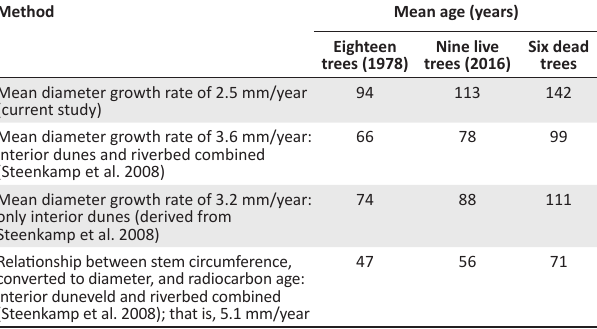
TABLE 1: Age calculations for Vachellia erioloba trees in the interior duneveld at the Dankbaar site using mean stem diameter of the 18 originally marked trees in 1978, the nine remaining live trees recorded in 2016 and the six dead trees last measured stem diameter when last surveyed as alive, derived by different methods.